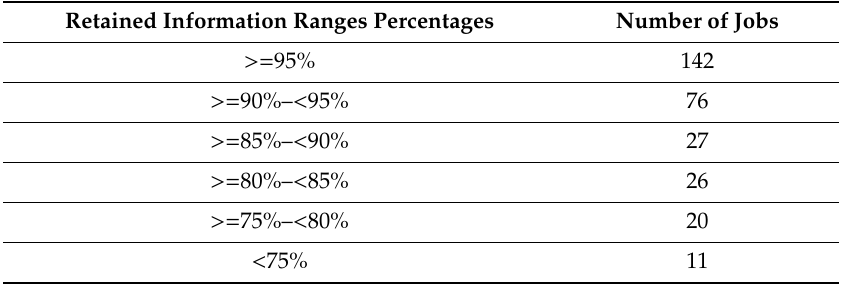
Table 4. Principal component analysis (PCA)—two principal components retained